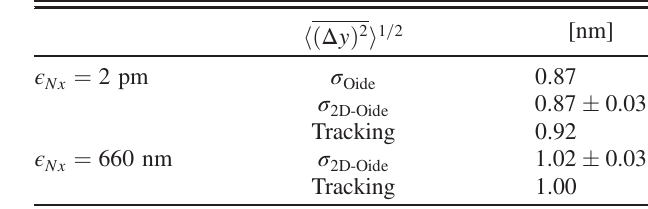
TABLE III. Contribution to beam size from radiation evaluated by σ , σ 2 , and tracking. Oide D-Oide